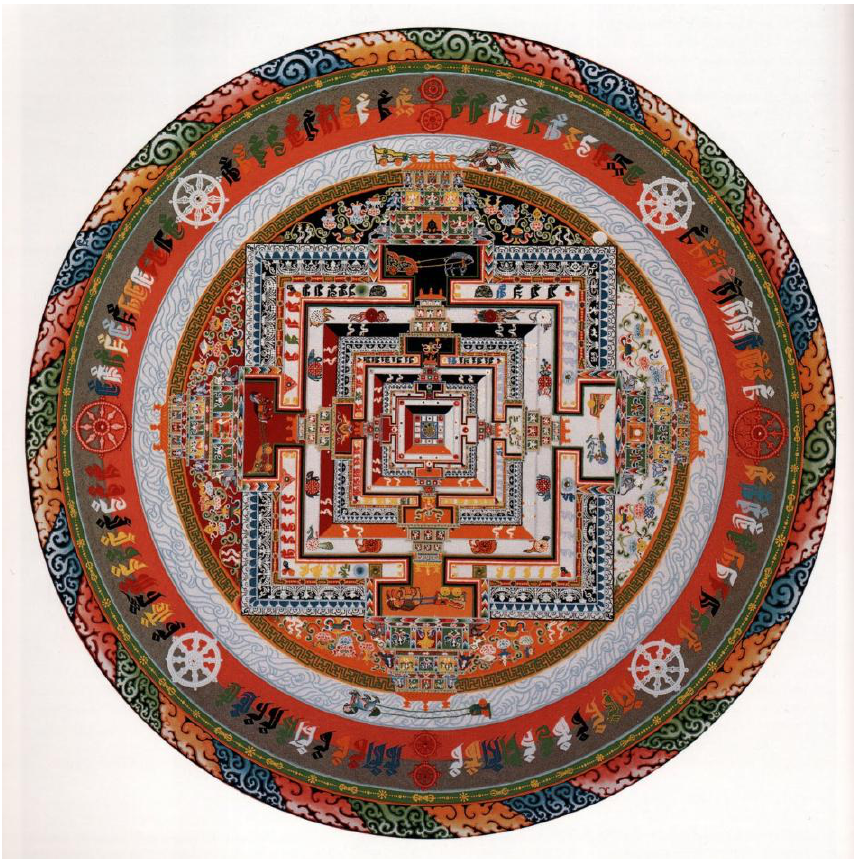
Fig. 1: Kālacakra sand mandala. Photograph by Martin Brauen. Reproduced with